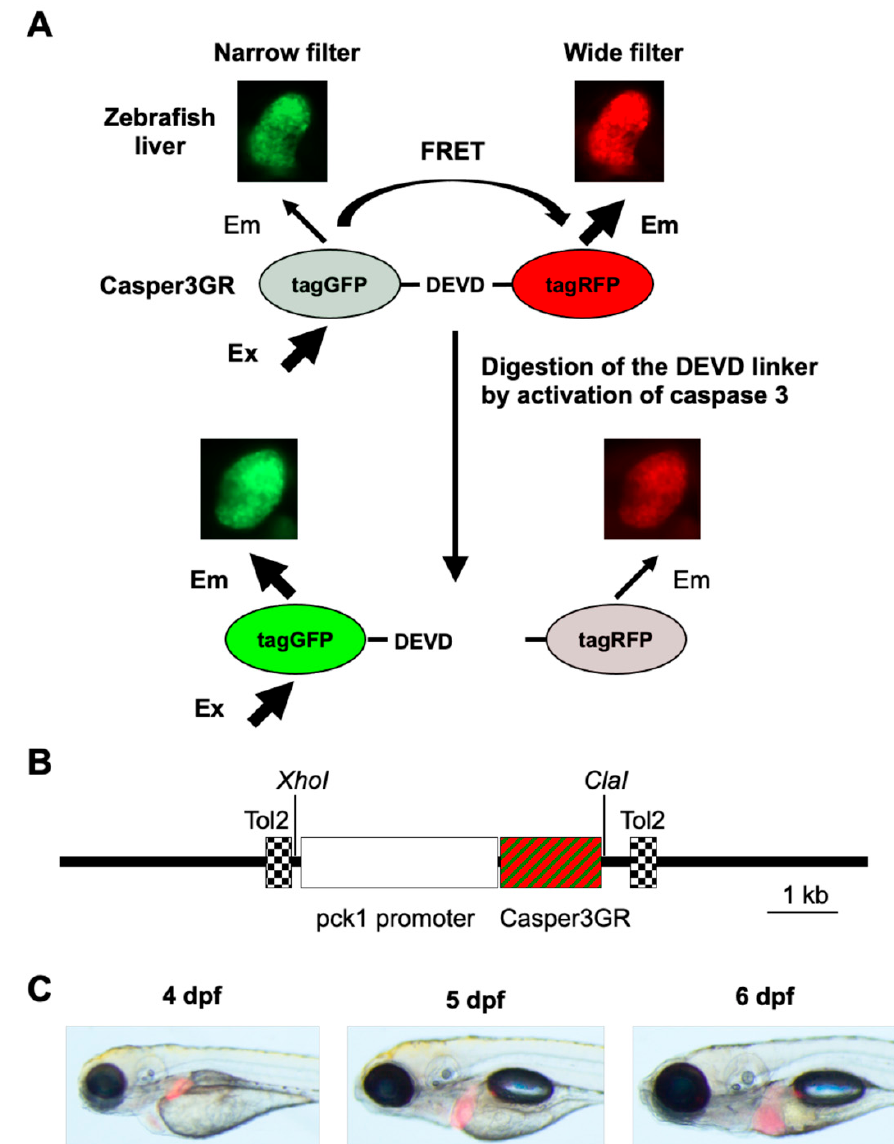
Figure 1. Assessment of hepatic apoptosis in zebrafish using FRET-based imaging. ( A ) FRET-based imaging technique developed in this study. Zebrafish expressing Casper3GR in hepatocytes were subjected to in vivo fluorescent imaging. When caspase 3 is not activated in the hepatocytes, the linker between tagGFP and tagRFP is not digested, resulting in FRET (i.e., excitation at the absorbance wavelength of tagGFP causes emission by tagRFP). When caspase 3 is activated in the hepatocytes, the linker is digested, which causes a decrease in FRET efficiency. In vivo fluorescence images of zebrafish liver obtained using a narrow filter (Ex/Em: 460 – 480/505 – 530 nm) and wide filter (Ex/Em: 460 – 480/567 – 647 nm) are also shown. ( B ) Diagram of the transposon vector used in this study. The coding region of Casper3GR was placed downstream of the regulatory sequences of pck1 and cloned between two Tol2 sequences in the vector backbone to direct selective protein expression in hepatocytes. ( C ) In vivo fluorescence imaging of Tg (pck1:Casper3GR) at 4, 5, and 6 dpf. The bright-field, GFP filter (Ex/Em: 460 – 490/510 nm), and RFP filter (Ex/Em: 545 – 580/610 nm) images are merged.